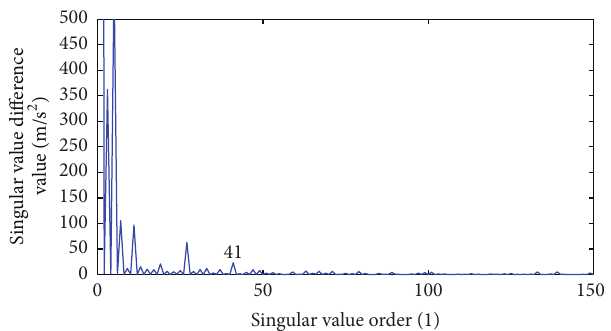
Figure 13: Singular value differential spectrum.